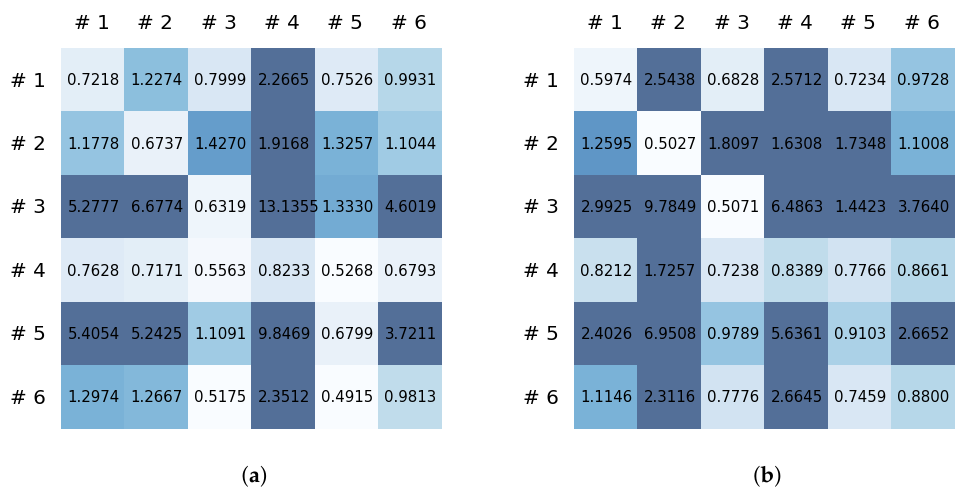
Figure 25. MSE values of the CNN model for ( a ) walking down stairs and ( b ) for walking up